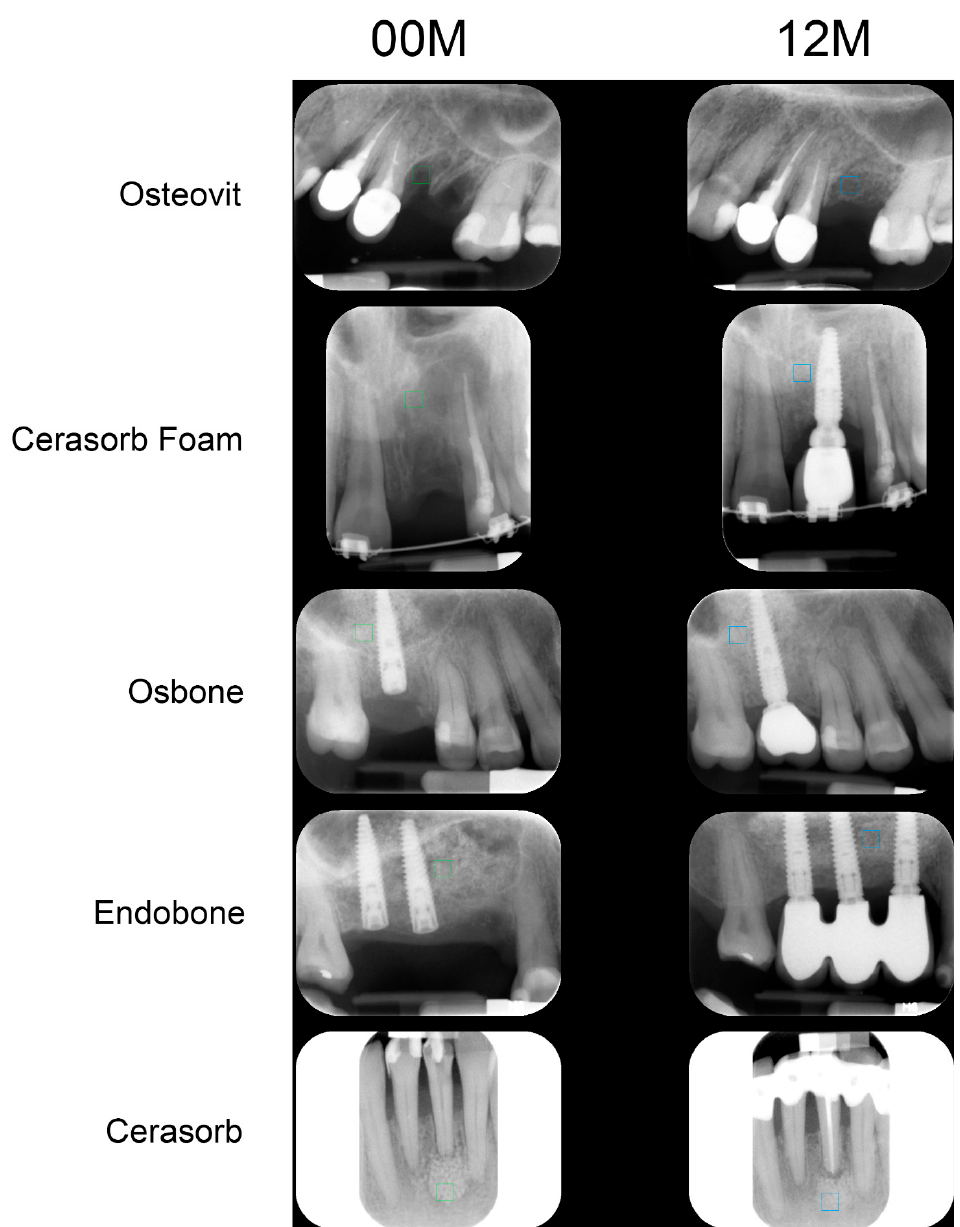
Figure 1. Examples of analyzed intra-oral radiographs (directly after implantation—00M, one year after surgery—12M). The exemplary regions of interest are marked in green and blue.